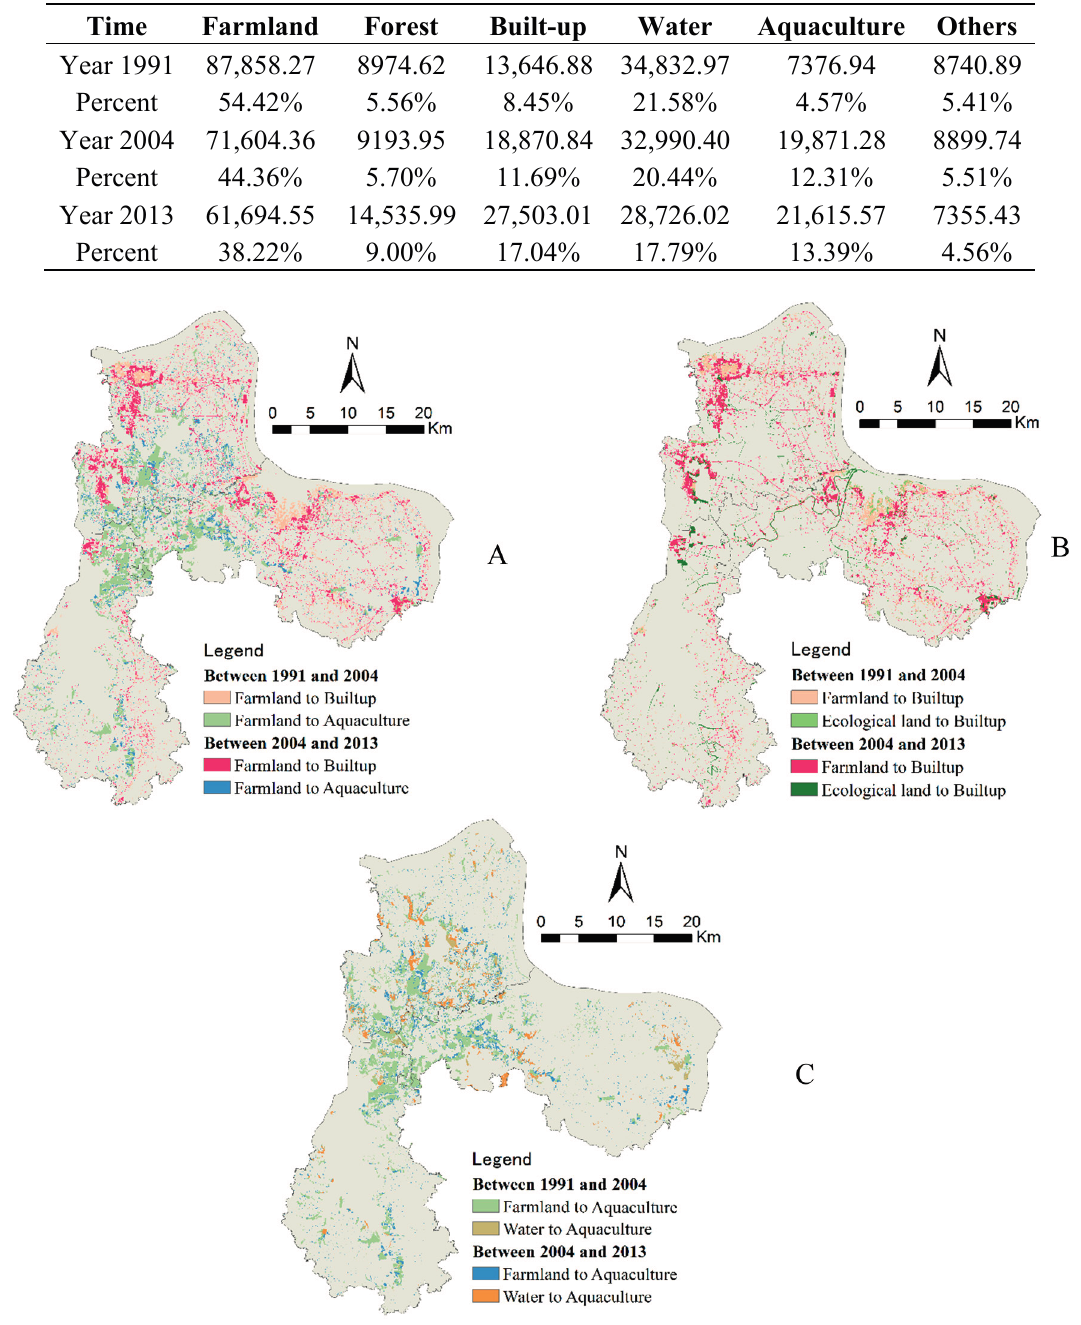
Table 1. Summary of land cover types between 1991 and 2013 (area unit: hectares).